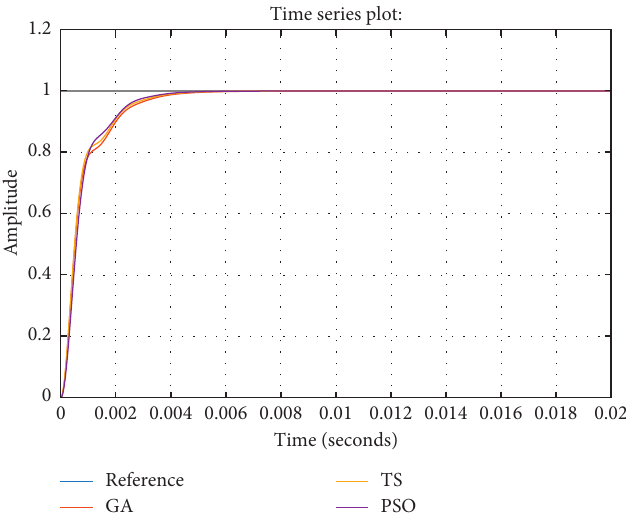
Figure 13: Result of response simulation of PI controller voltage with GA, TS, and PSO. Table 2: System responses by the PI controller. System responses by PI Entry